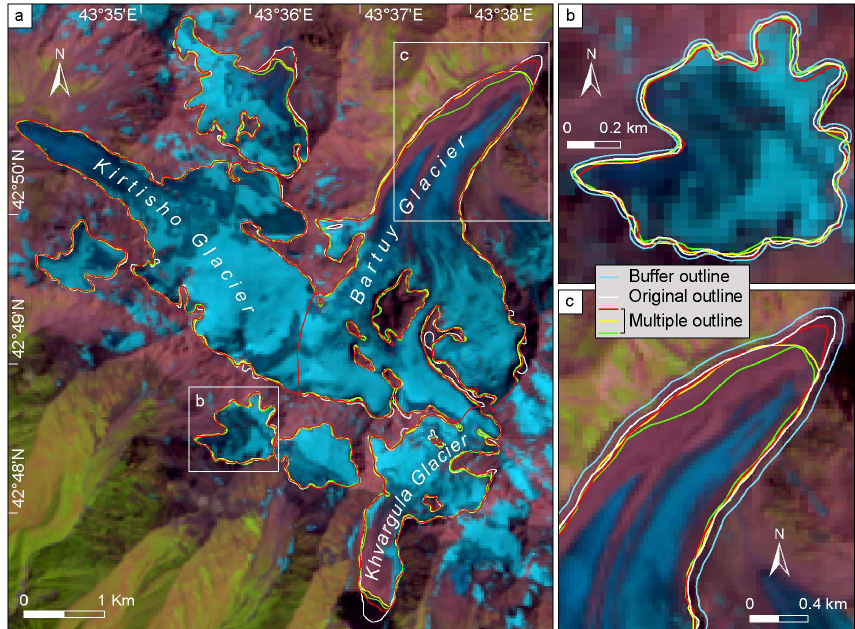
Figure 3. (a) Selected glaciers for multiple digitizing based on Landsat 5 TM scene (12 August 2000). (b) Manually mapped debris-free glacier outline with a half-pixel (15m) buffer interval. (c) Manually mapped debris-covered glacier outline with a two-pixel (60m) buffer interval (light blue). Image credit: (a) https://earthexplorer.usgs.gov (last access: November 2020).